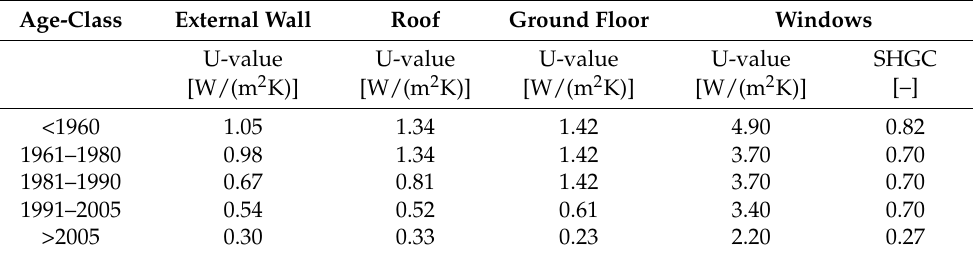
Table 2. Age-class attributes of the Belzoni district. U-value of the main structures and solar heat gain coefficient of the